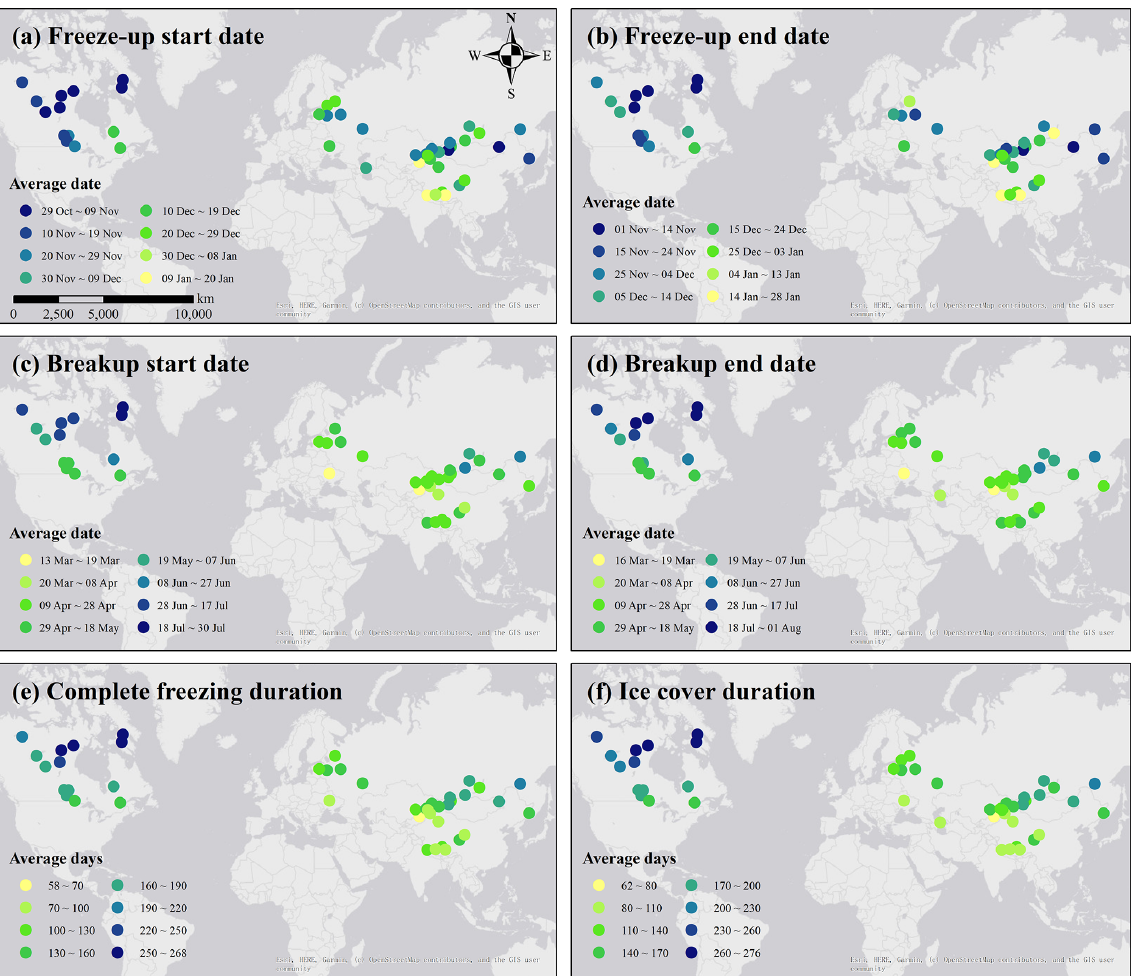
Figure 9. Average date/days of ice phenology for the study lakes for their entire lake ice phenology records extracted from SMMR and SSM/I–SSMIS data: (a) freeze-up start date, (b) freeze-up end date, (c) breakup start date, (d) breakup end dates, (e) complete freezing duration, and (f) ice cover duration. © OpenStreetMap contributors 2022. Distributed under the Open Data Commons Open Database License (ODbL)